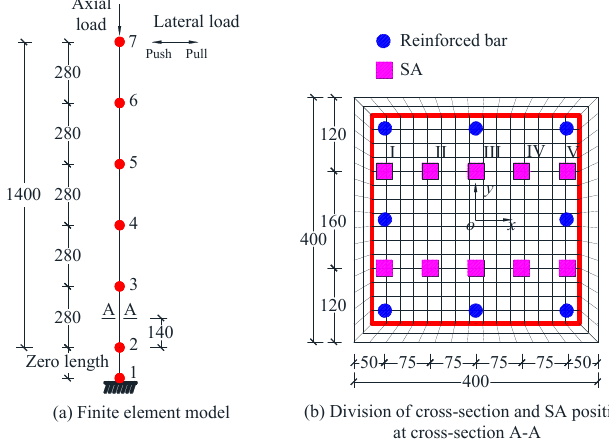
Figure 2. ( a ) Finite element model; and ( b ) division of cross section and SA position of RC column.